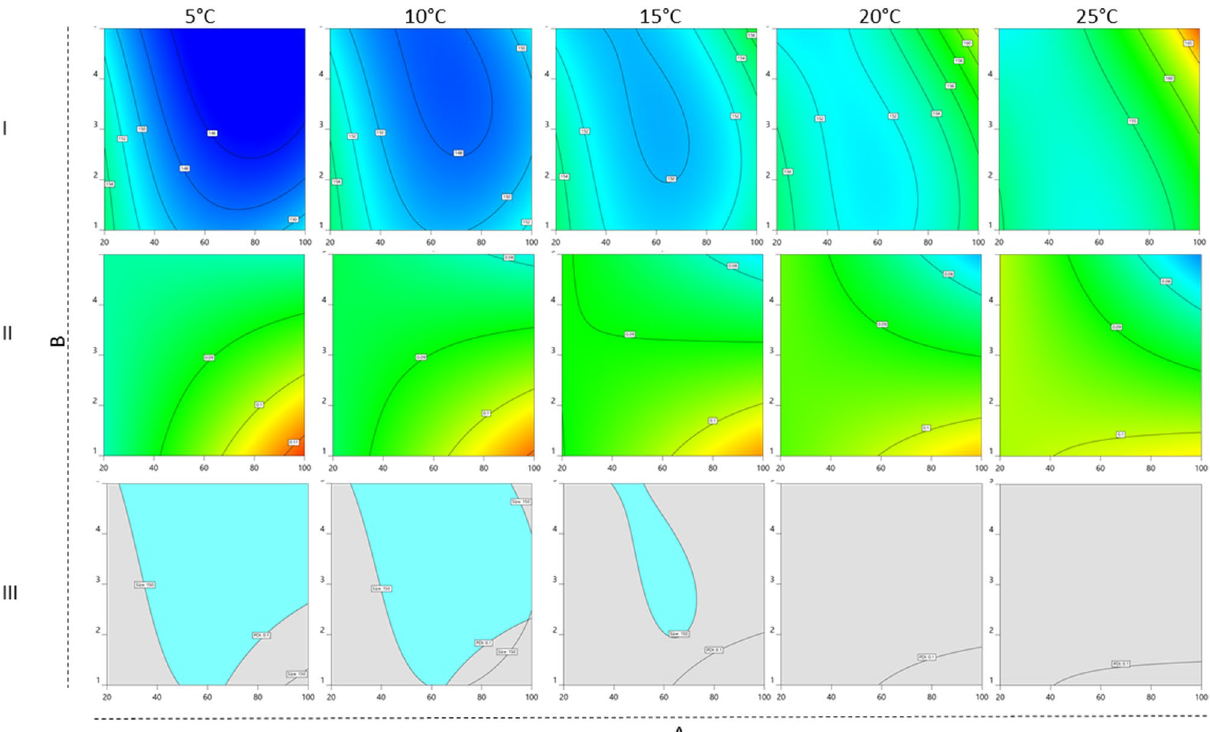
Figure 6. Contour plots generated in DesignExpert depicting A (amplitude, %, x-axis) versus B (duration, min., y-axis) at fixed C (temperature, °C, columns). Size (row I) and PDI (row II) responses at fixed variable C as indicated at the top of each column. Colors from warm to cool indicate values from high to low. Row III depicts overlay plots of the two responses where the criteria of size < 150 nm and PDI < 0.1 are fulfilled at each